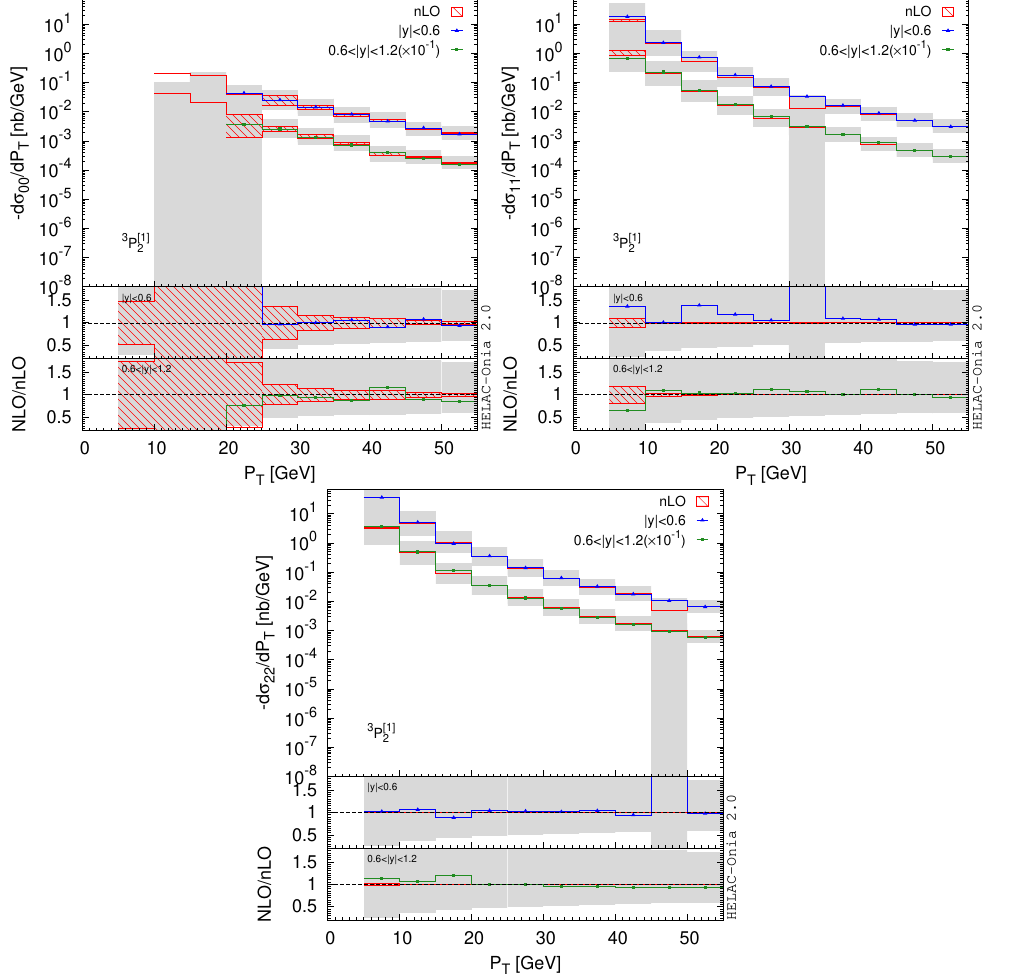
Figure 23 . Comparisons of spin-dependent differential cross sections for the Fock state 3 P [1] between our nLO calculations and the complete NLO calculations. They are similar to figure